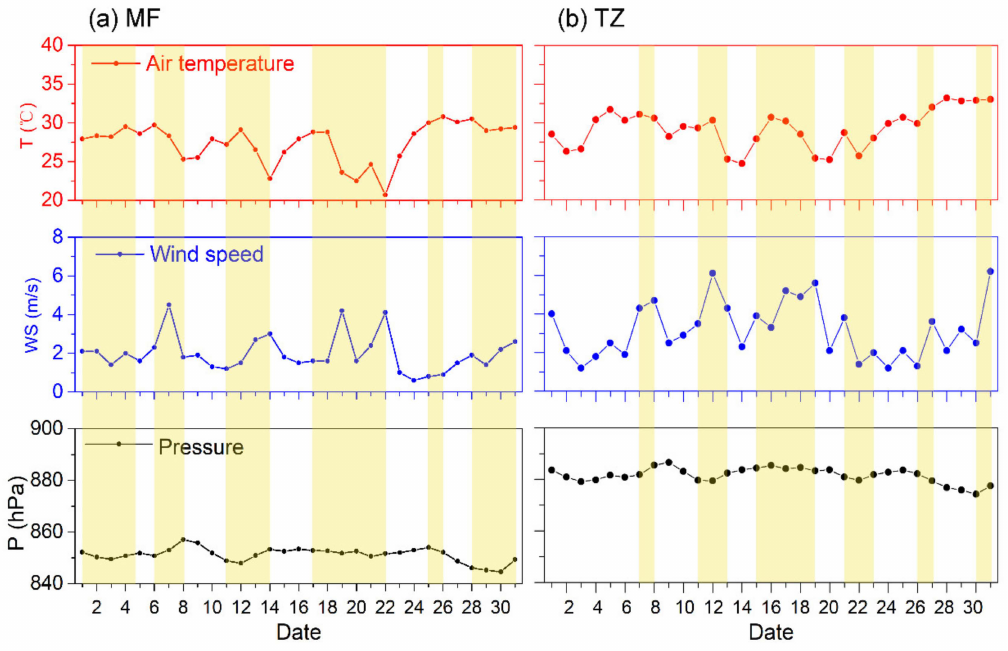
Figure 2. Temporal variations of temperature, wind speed, and surface pressure in the surface layer during July 2021 in MF ( a ) and TZ ( b ). The yellow shaded area represents the dust